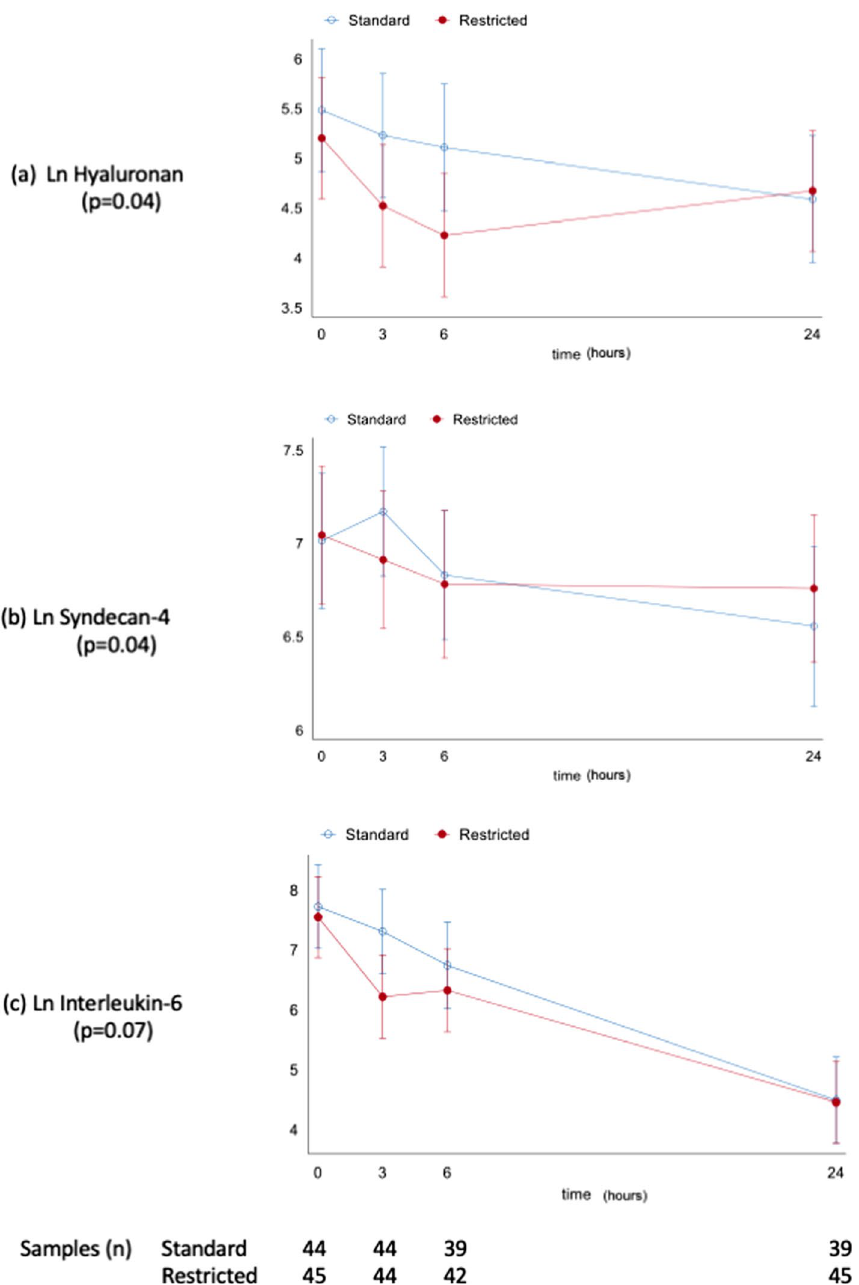
Fig. 2 Log (Ln) linear predicted means (with 95% confidence intervals) against time (h) for Hyaluronan, Syndecan‑4 and Interleukin‑6 for usual (standard) care and restricted fluid resuscitation. P values for interaction term for group*fluid; See Additional files 1 and 2 for details of